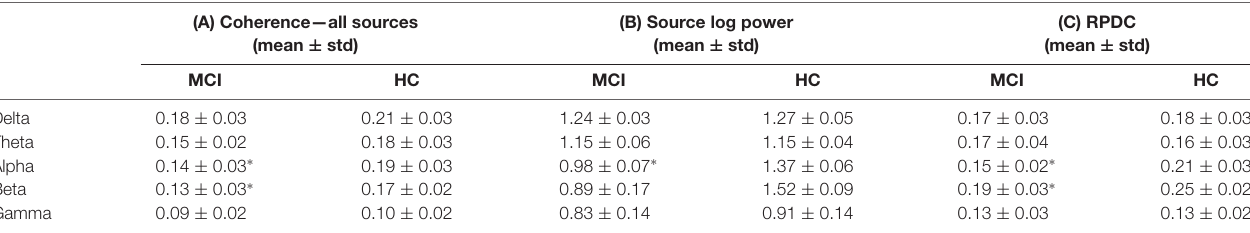
TABLE 2 | Global Electroencephalography (EEG) differences between controls and mild cognitive impairment